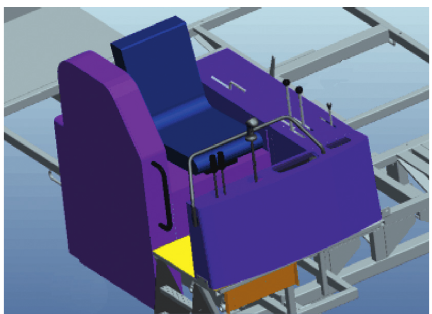
Figure 13: Overall layout model of cab maneuvering space.